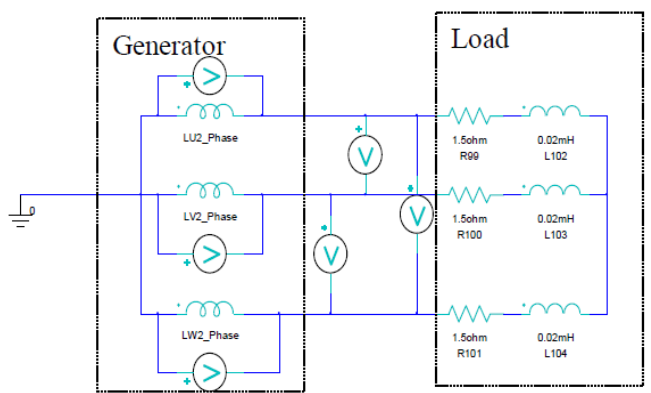
Figure 12. Circuit model.